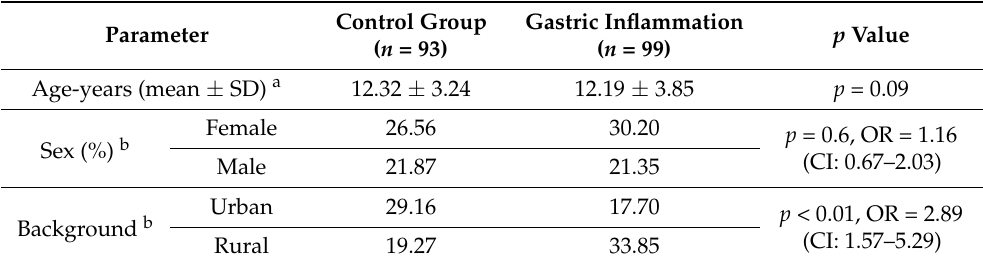
Table 1. Demographic characteristic comparison of controls versus subjects with inflammatory modifications of the gastric